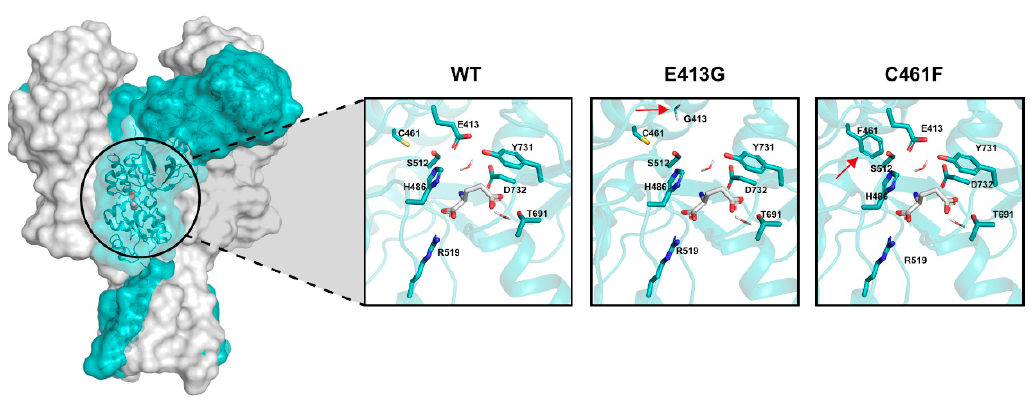
Figure 9. Structure of human GluN1/GluN2A NMDA receptor (PDB accession code: 4TLM). The GluN2B subunit is colored in light blue. The insights show the glutamate binding domain of the wild-type (WT) receptor and the two structural variants Glu413Gly (E413G) and Cys461Phe (C461F). Each window focuses on the docked glutamate (white molecule) and the crucial residues that directly participate to the interaction. Red arrows point to the residue substitution of each of the two structural variants.